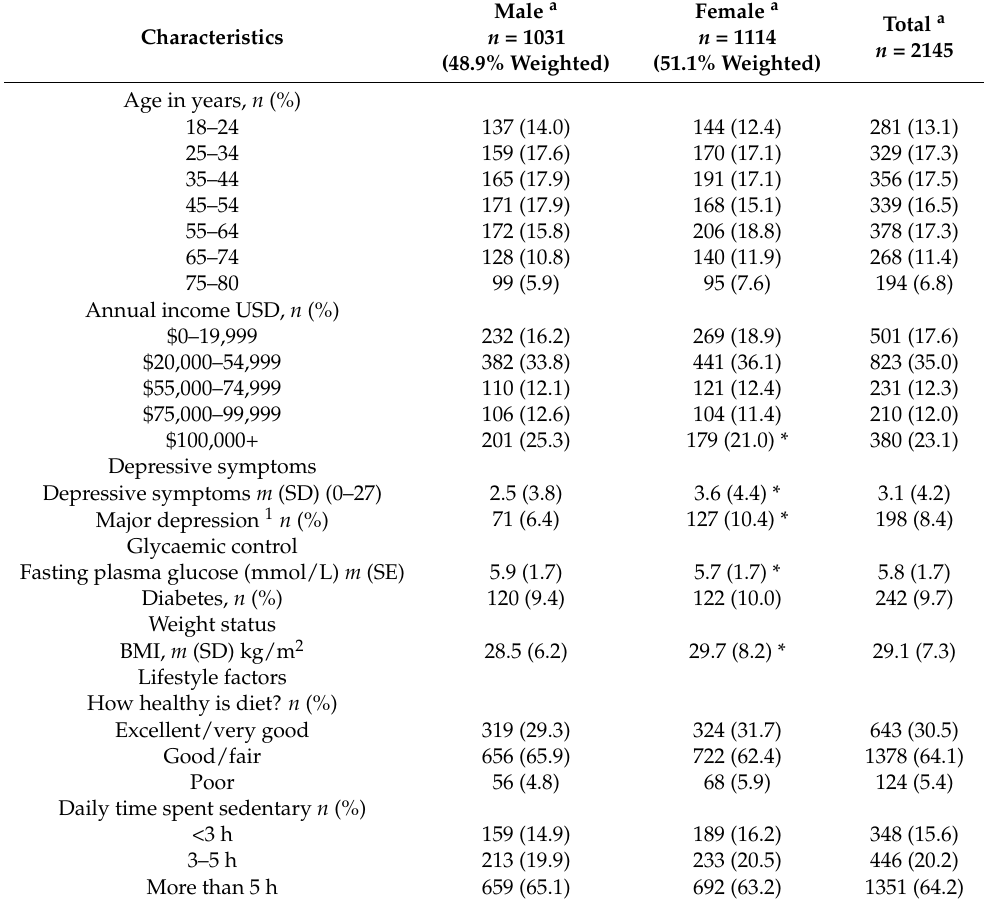
Table 1. Participant